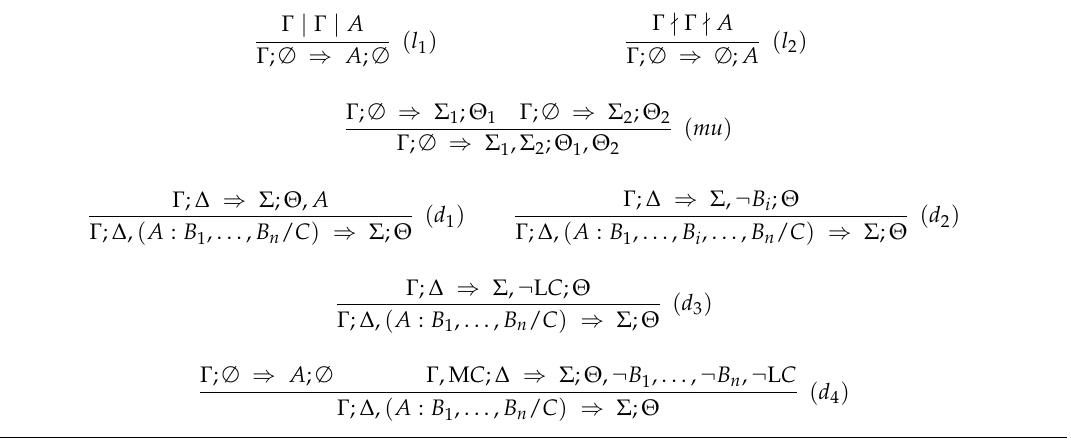
Figure 4. Rules for default sequents of the calculus B 3